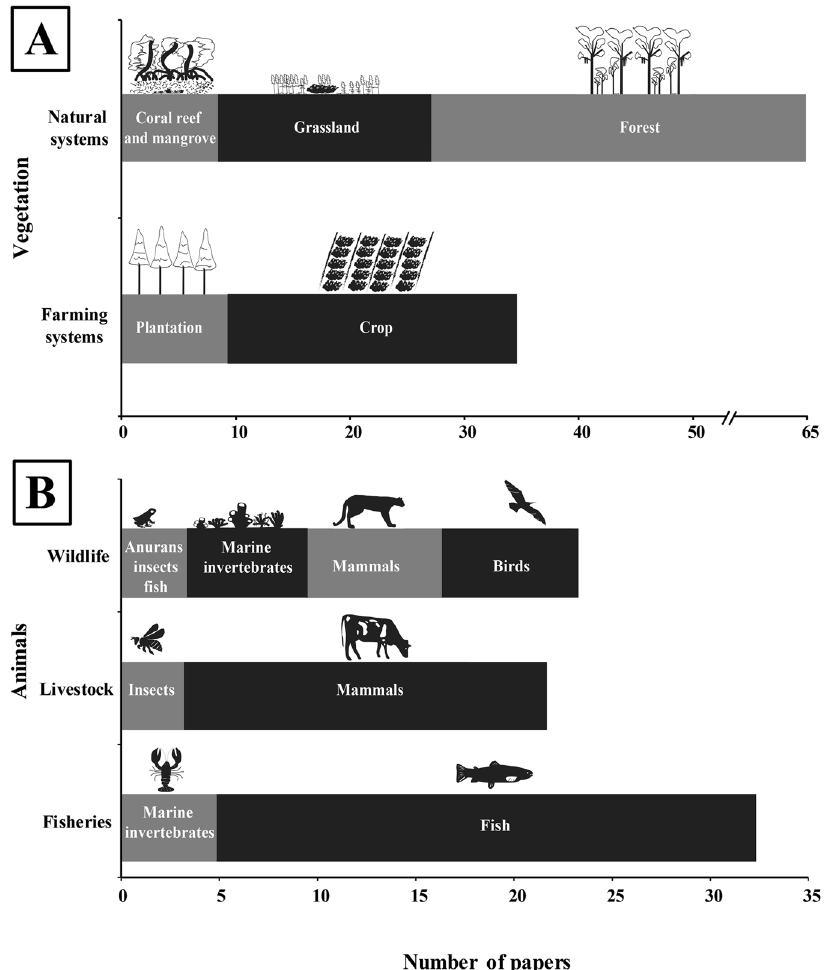
Fig. 6 Graphs illustrating the quantity of socio-ecological studies on fl ora and fauna. Number of socio-ecological papers examining the fl ora ( n = 100) ( A ) and fauna ( n = 79) ( B ) issues in this